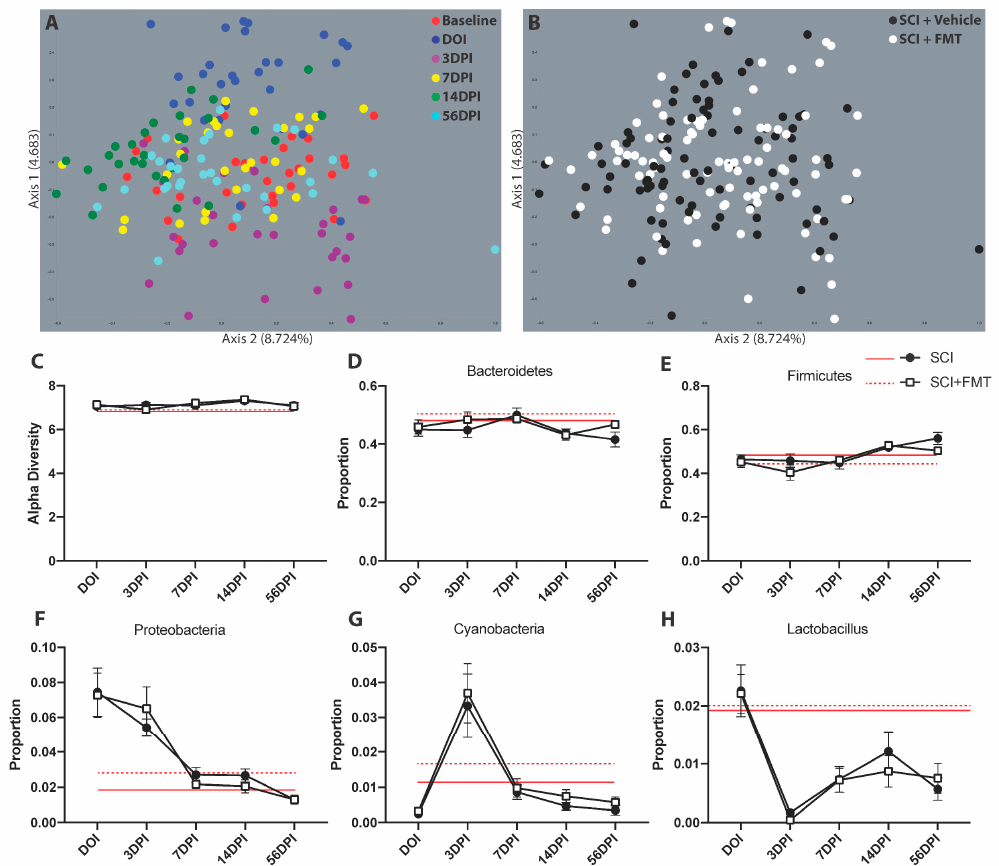
Figure 3. FMT from anxious donors did not prevent gut dysbiosis following SCI. ( A ) PCoA plot of beta diversity shows the diversity between fecal samples over time on the day of injury (DOI), 3-, 7-, 14- and 56-days post-injury (DPI). ( B ) The same PCoA plot is shown with the colors representing the groups instead of timepoints. Axis 1 and 2 explain 4.683% and 8.724% of the variance between samples, respectively. ( C ) There was no effect of injury or treatment on the alpha diversity. The four most abundant operational taxonomic units at the phylum level also show no differences between experimental groups in the proportion of ( D ) Bacteroidetes, ( E ) Firmicutes, ( F ) Proteobacteria and ( G ) Cyanobacteria. ( H ) The proportion of the genus Lactobacillus was reduced after SCI but not affected by FMT. Red lines represent baseline values. Error bars represent standard error